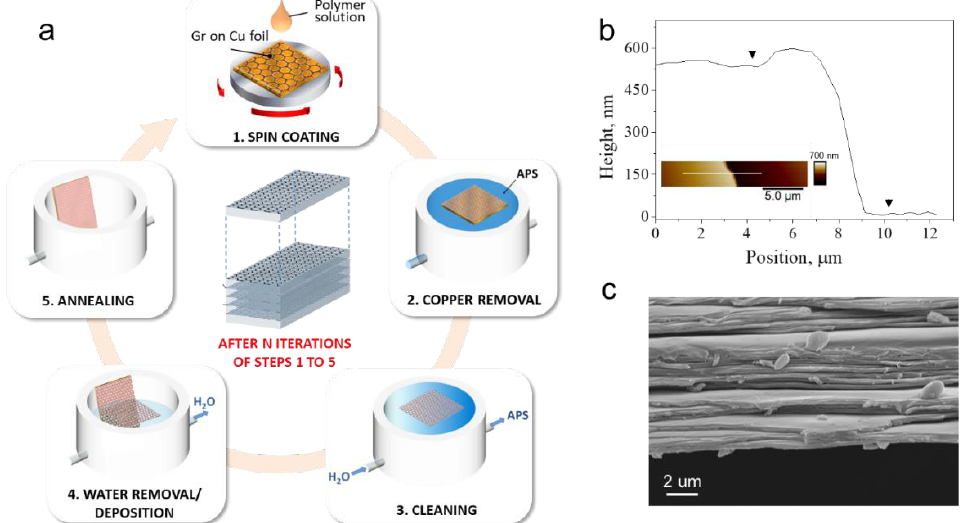
Figure 1. ( a ) Schematic illustration of the iterative ‘lift -off/float- on’ process combined with wet depositions adopted to produce the Gr-PMMA nanolaminates. ( b ) Thickness evaluation of the single Gr-PMMA layer deposited on a Si wafer: representative cross-section of the scratch and AFM image as inset. ( c ) SEM image in the cross-section plane of the nanolaminate.